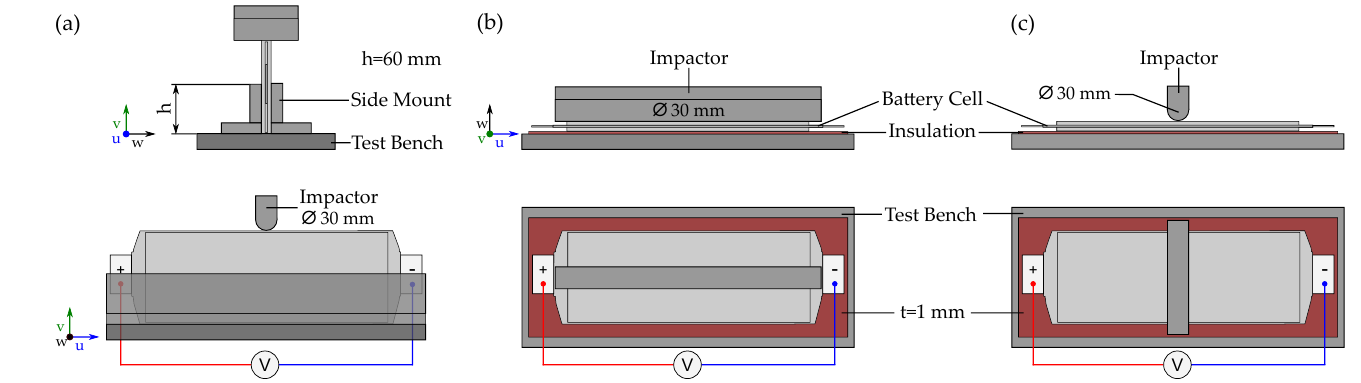
Figure 2. Visualization of the used experimental setup for mechanical cell testing: ( a ) Lateral indentation test setup with test bench, L-shaped sample holders and the ∅ 30mm cylindrical impactor. ( b ) Shows the cylindrical indentation test along the long cell side ( u ) and ( c ) the cylindrical indentation test setup along the short cell side ( v )